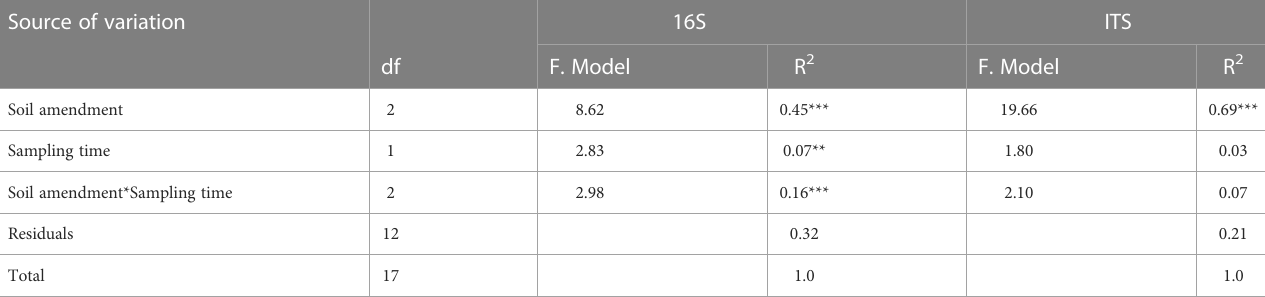
TABLE 2 PERMANOVA analysis of soil treatment effects on bacterial and fungal community composition structure based on weighted uniFrac distance. Source of variation